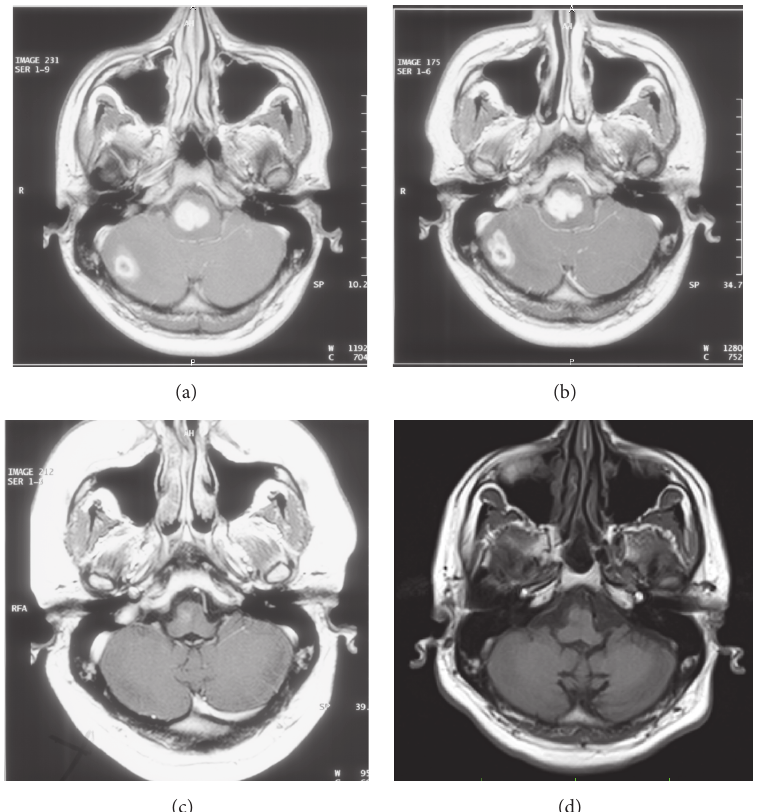
Figure 1: MRI scan during treatment phases. At diagnosis (a), one month after diagnosis on HREZ (b), after two months of therapy based on resistance assay (c), and after five years